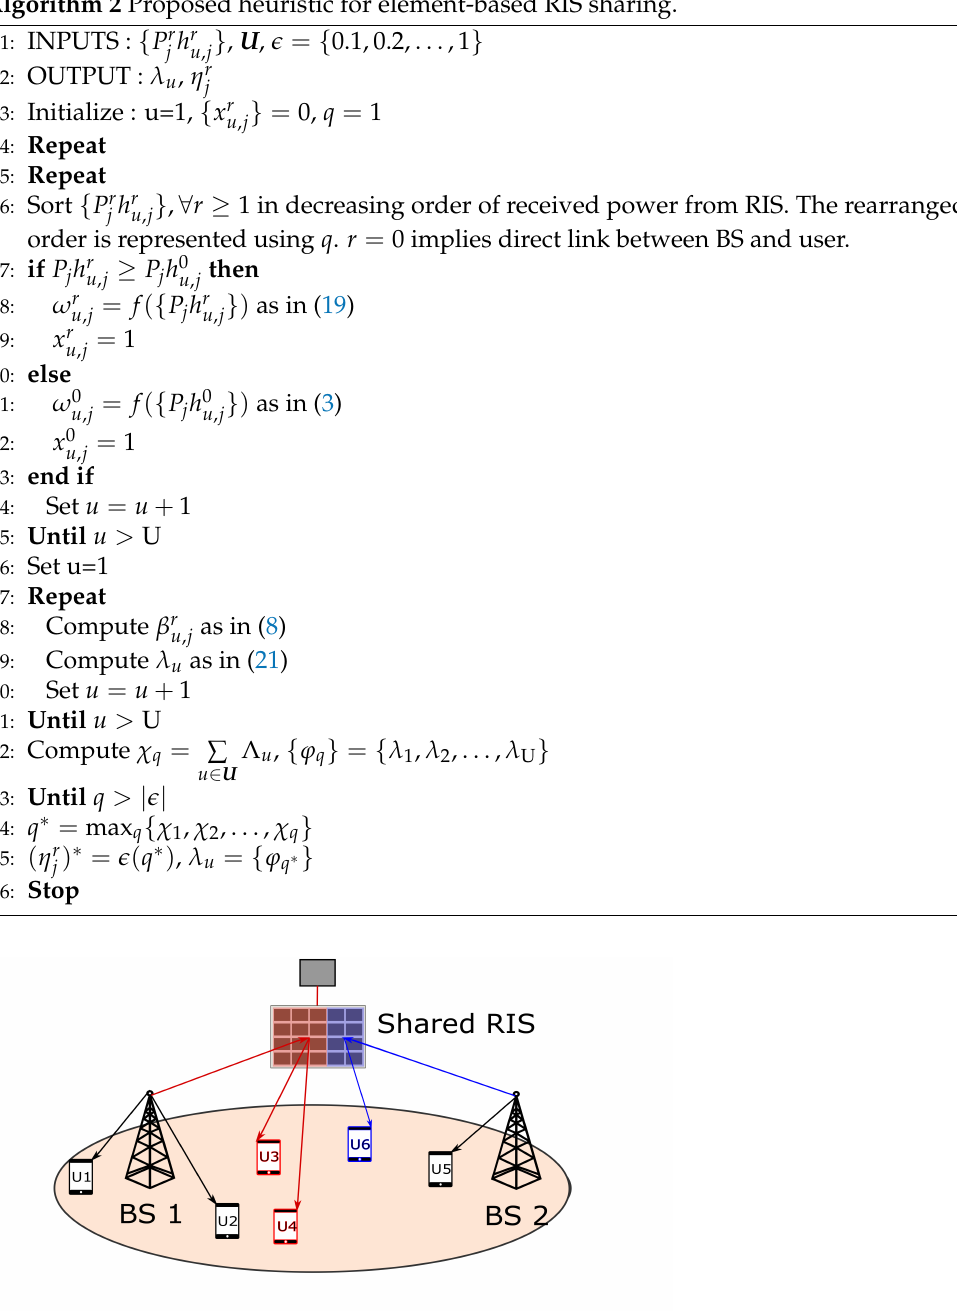
Algorithm 2 Proposed heuristic for element-based RIS sharing.